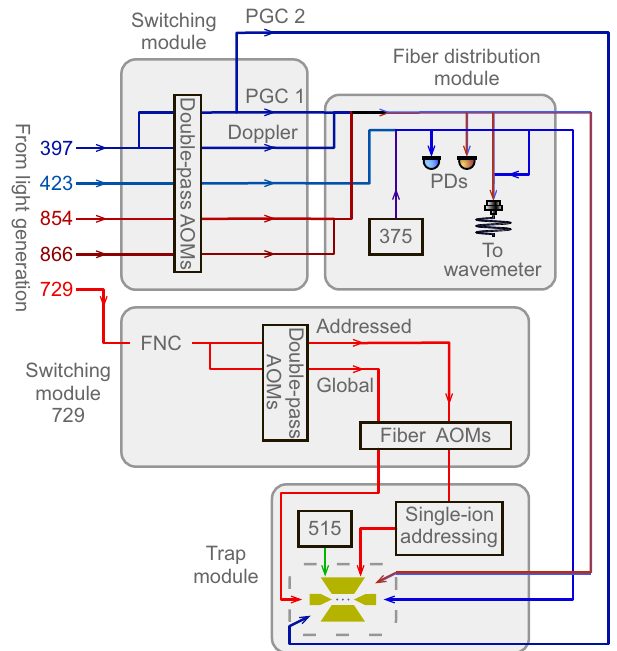
FIG. 5. Schematic of light delivery, switching, and addressing modules. Light is fiber delivered to dedicated switching modules utilizing free-space double-pass AOMs, after which overlap- ping and fiber routing to their final destination is handled on a fiber distribution module for incoherent interactions. Photodi- odes (PDs) are placed throughout the beamline for continuous power monitoring. The qubit laser system has similar switching and routing capabilities, with the addition of fiber noise cancela- tion (FNC), and fiber AOMs for improved the on-off extinction ratio, bichromatic modulation for Mølmer-Sørensen interactions, and light field parameter control. One of two approaches is used to deliver addressed light; see Figs. 6 and